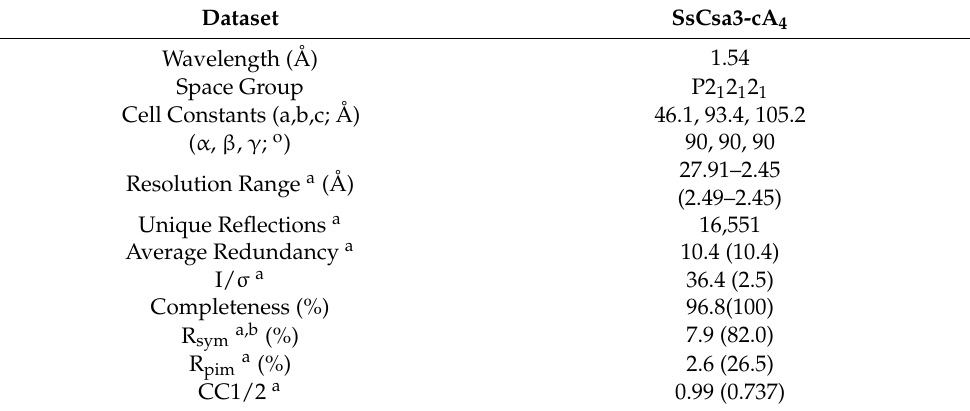
Table 1. Data collection.